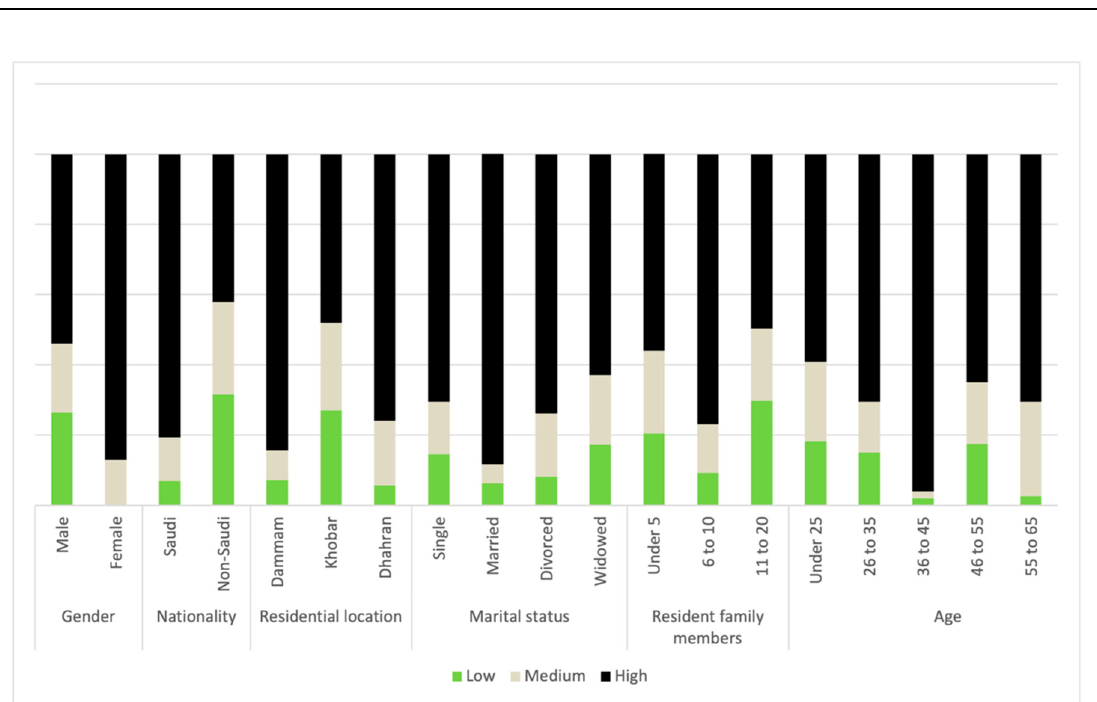
Figure 3. Relationship between behavior patterns and demographic features.